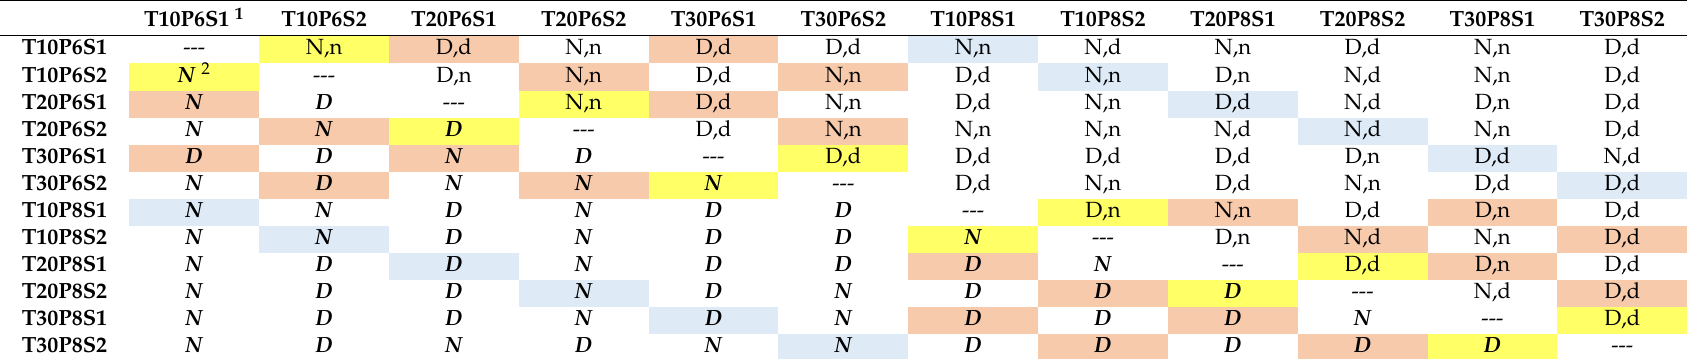
Table 5. Comparisons of the dimensionless erosion rates. The capital letters indicate results of the pairwise non-parametric Wilcoxon test of the medians and lowercase letters indicate the results of the parametric Tukey–Kramer HSD comparison of the means for the montmorillonite soil. Wilcoxon results for the vermiculite-dominated soil are in the lower left corner and are italicized and bolded. Yellow, blue, and orange cells indicate salinity, pH, and temperature comparisons,